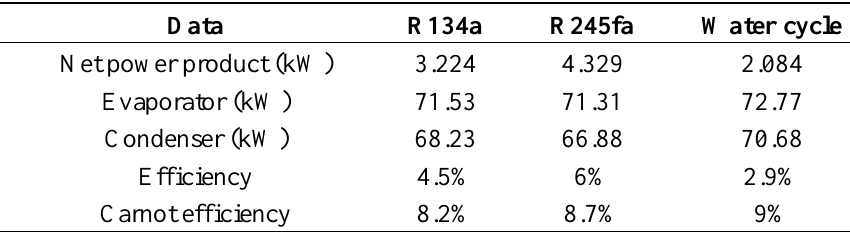
Table 5. Characteristics of thermodynamic